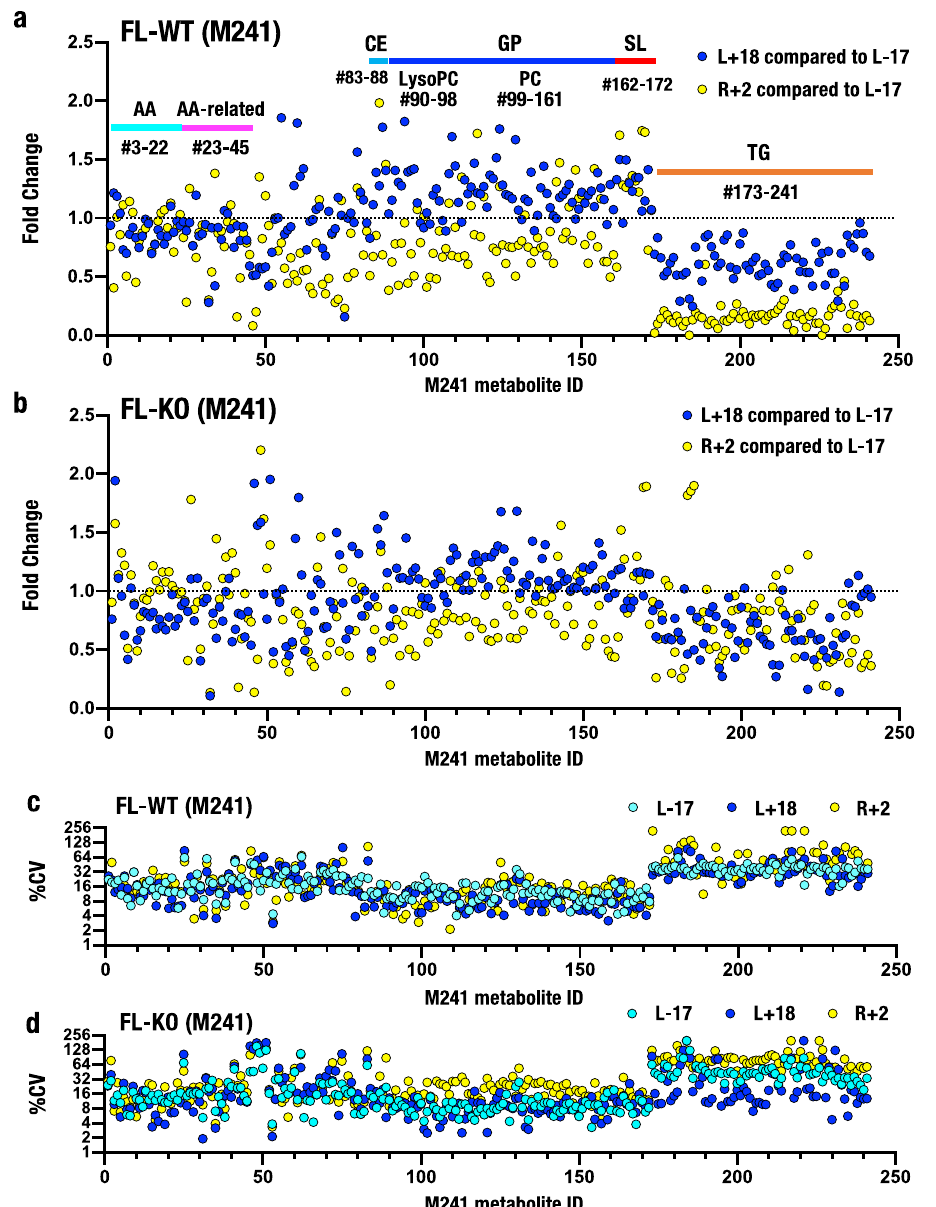
Fig. 2 Plasma metabolite levels measured during and after space fl ight. a , b Metabolic changes in plasma collected from the tails of WT ( a ) and Nrf2 KO ( b ) mice (dataset M241). Fold changes in plasma metabolite levels at L + 18 (blue dots) compared to L-17 and R + 2 (yellow dots) compared to L-17. c , d CV values of dataset M241 in the plasma of WT ( c ) and Nrf2 KO ( d ) mice at three time points: WT L-17 (cyan), L + 18 (blue) and R + 2 (yellow) and Nrf2 KO L-17 (cyan), L + 18 (blue) and R + 2 (yellow). Data are presented as the CV (%) of the metabolite concentrations. The horizontal axis indicates